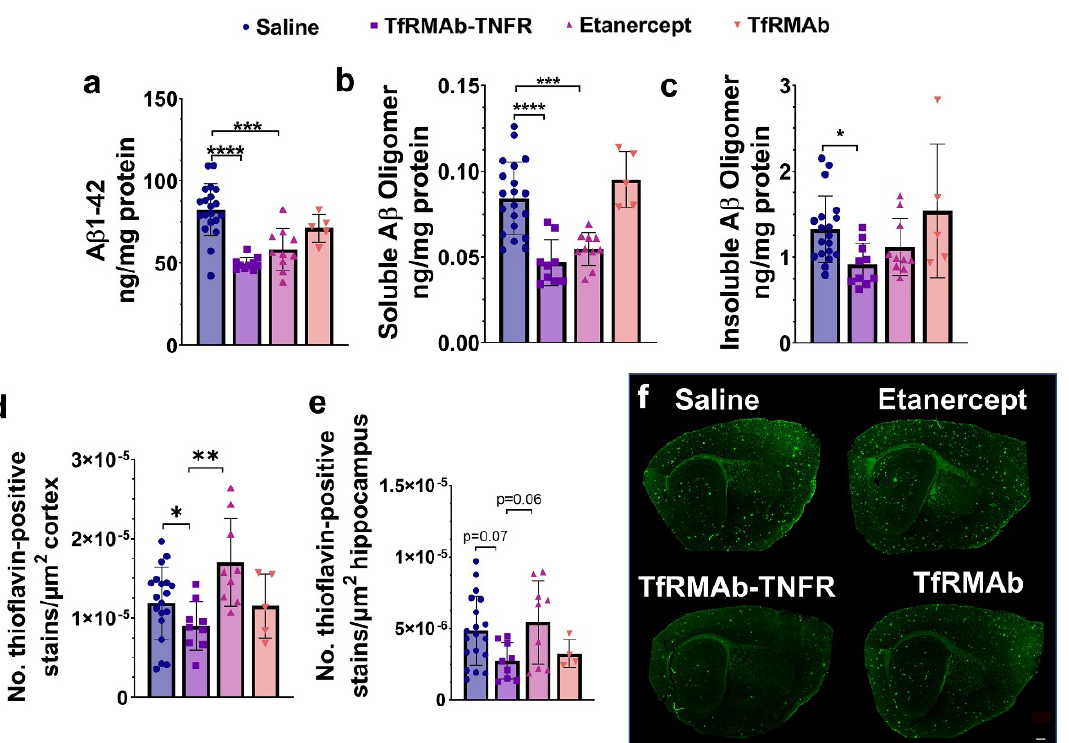
Figure 2. Effect of TfRMAb-TNFR on insoluble A β (1-42) and high-molecular-weight A β assemblies. TfRMAb-TNFR and etanercept reduced insoluble (Gu-HCl-soluble) A β (1-42) ( a ) and soluble (TBS-soluble) high-molecular-weight oligomeric A β ( b ) in cerebrum homogenates compared to the saline-treated mice. TfRMAb-TNFR, but not etanercept, significantly reduced insoluble (Gu-HCl-soluble) oligomeric A β in the cerebrum homogenates ( c ). TfRMAb-TNFR-treated mice also had a lower number of Thio-S-positive A β plaques compared to the saline-treated mice ( d ), and a similar trend was observed in the hippocampus ( e ). Representative sagittal brain section images of Thio-S-stained mature A β plaques ( f ). Scale bar = 200 µ m. Data are presented as mean ± SD of n = 4–20 per treatment group, and data were analyzed using the one-way ANOVA with the Holm Sidak’s post hoc test. * p < 0.05, ** p < 0.01, *** p < 0.001, **** p < 0.0001 for the indicated